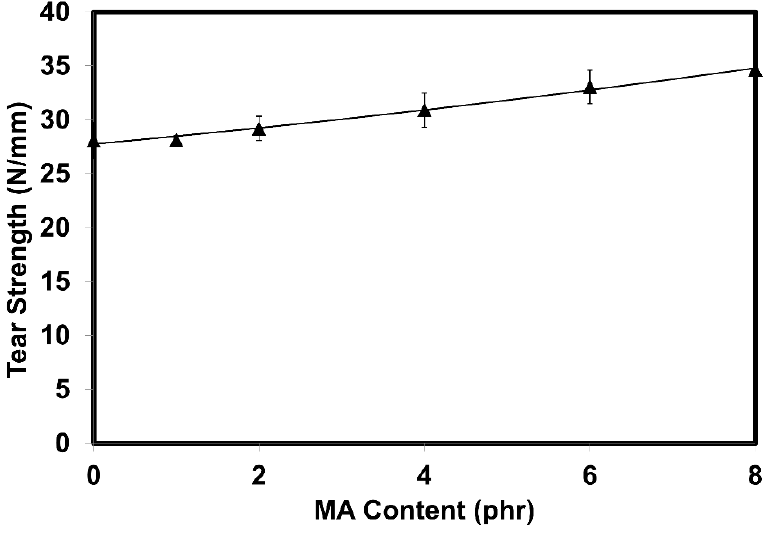
/ HNT and MNR / HNT Figure 8. Tear strength of NR/HNT and MNR/HNT composites. Figure 8. Tear strength of NR Figure 8. Tear strength of NR/HNT and MNR/HNT composites.